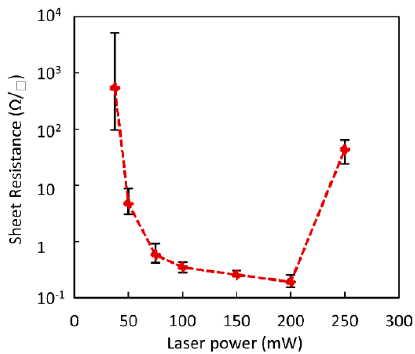
Figure 4. The sheet resistance as a function of laser power